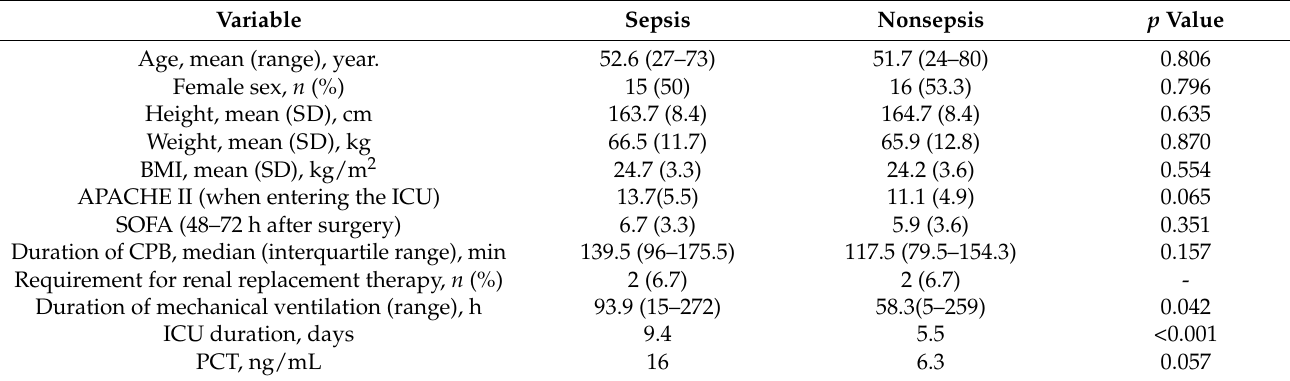
Table 1. Clinical characteristics of the subjects.